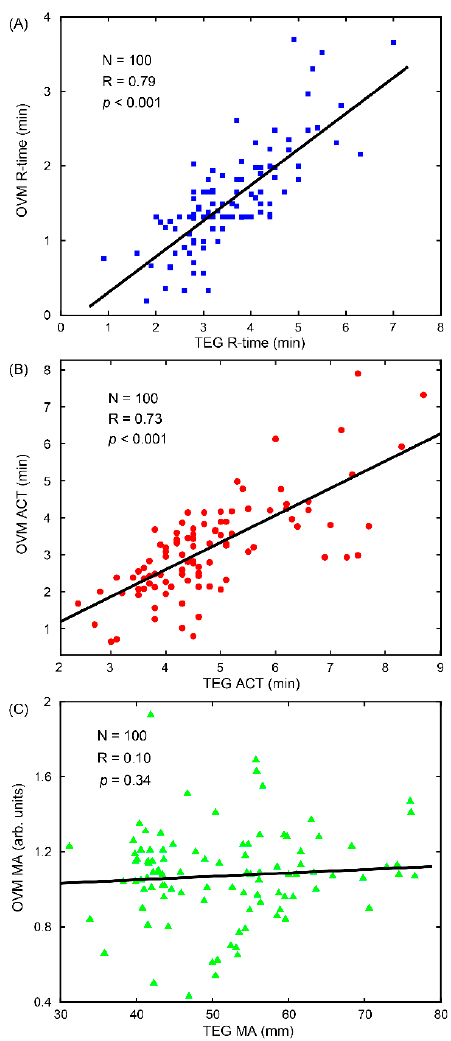
Figure 6. A comparison of variable coagulation parameters acquired from our technique versus TEG. ( A ) R-time, ( B ) ACT-time, and ( C ) MA obtained with the OVM and TEG with 100 different porcine blood samples. R-time and ACT-time showed a strong positive correlation with the gold standard but MA presented a weak correlation, which is worthy of